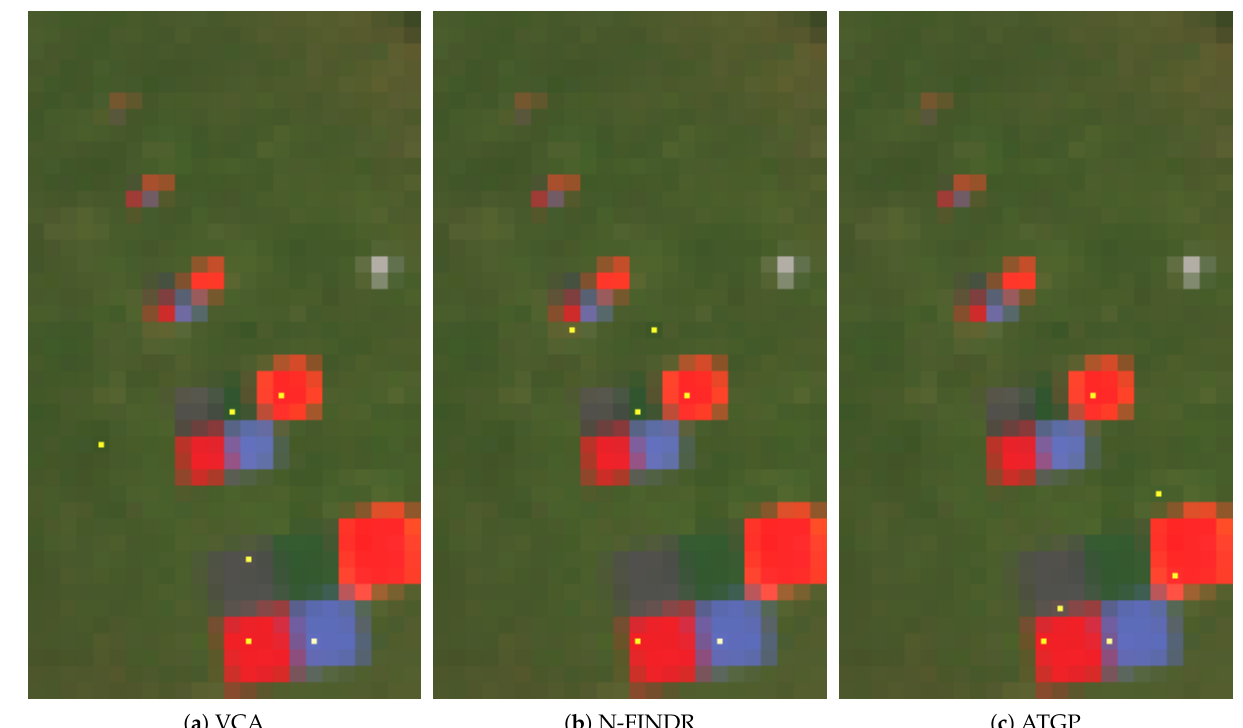
Figure 10. Locations of endmembers extracted from algorithms working under the pure pixel assumption on the subset All Targets Masked using as input number of endmembers k = 6.